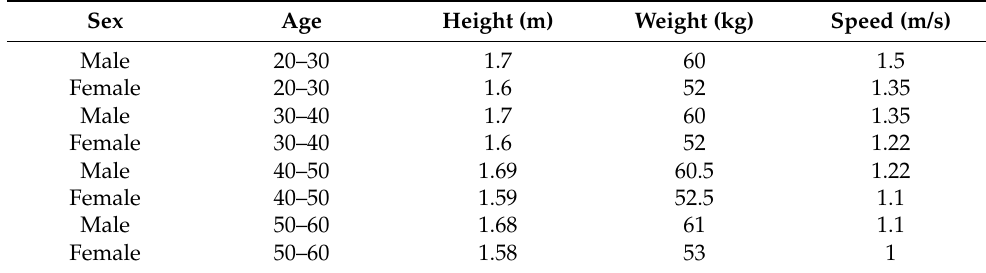
Table 1. Evacuation speed of different